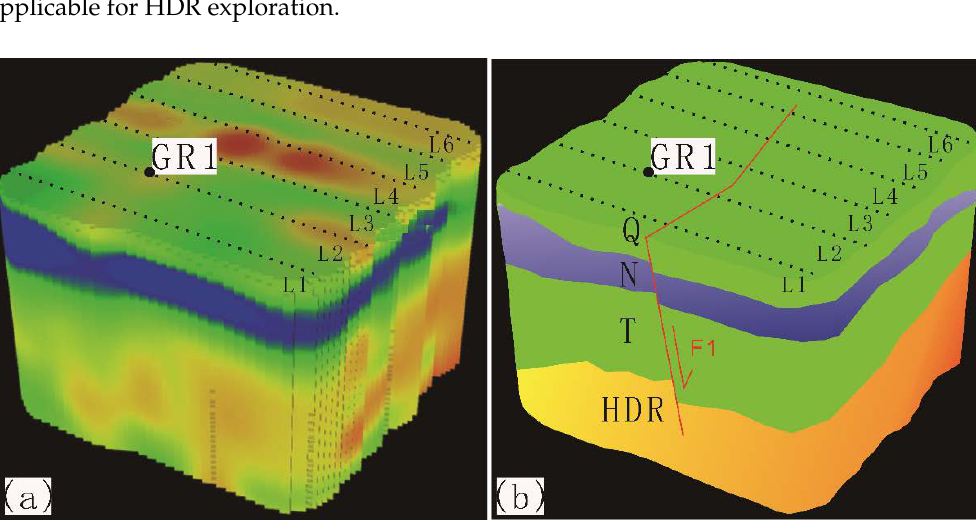
Figure 8. ( a ) Three-dimensional resistivity inversion map and ( b ) geological interpretation map of the WFEM data.